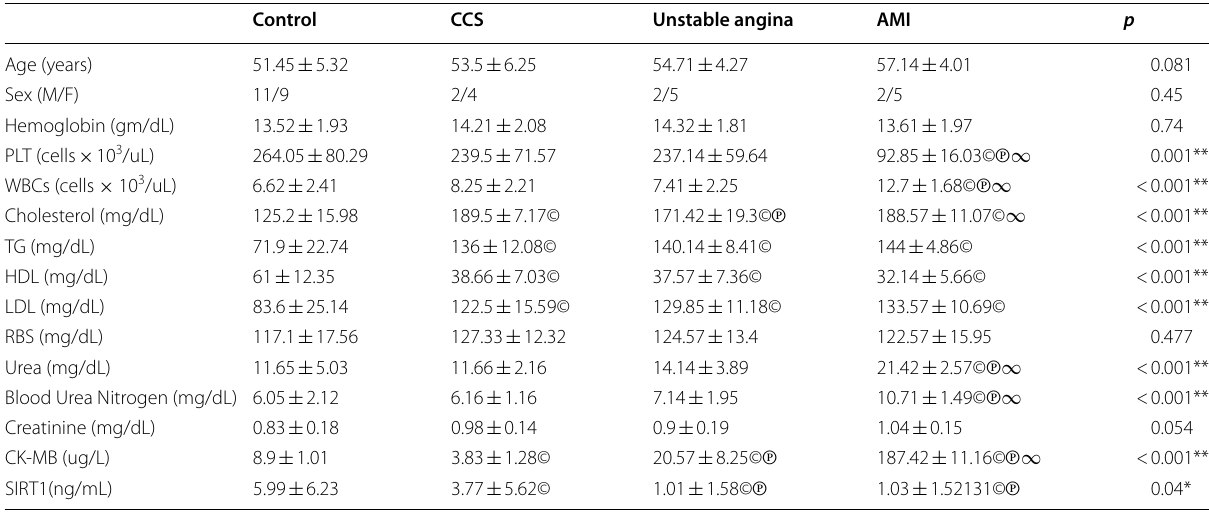
CCS: chronic coronary syndrome; UA: unstable angina; AMI: acute myocardial infarction; PLT: platelet count; WBCs: white blood cells; TG: triglycerides; HDL: high- density lipoprotein; LDL: low-density lipoprotein; RBS: random blood sugar; CK-MB: creatine kinase-MB; SIRT1: sirtuin1; *: p < 0.05: statistically significant; **: p < 0.001: highly statistically significant; ©: significant difference with control; ℗ : significant difference with CCC;